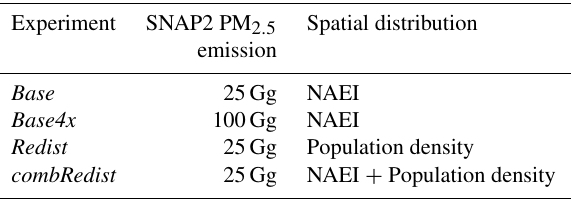
Figure 4. Locations of the ClearfLo measurement sites used in this work. London North Kensington is an urban background site, Lon- don Marylebone Road is a roadside site, Harwell and Detling are rural background sites (source: Ots et al., 2016a). Underlying map from ©OpenStreetMap contributors. Table 2. Summary of the four experiments for PM 2 . 5 emissions from SNAP2. In all experiments, PM 2 . 5 is split into three compo- nents as follows: 48% is SFOA, 26% EC, and 26% other/mineral PM (as in Fig.